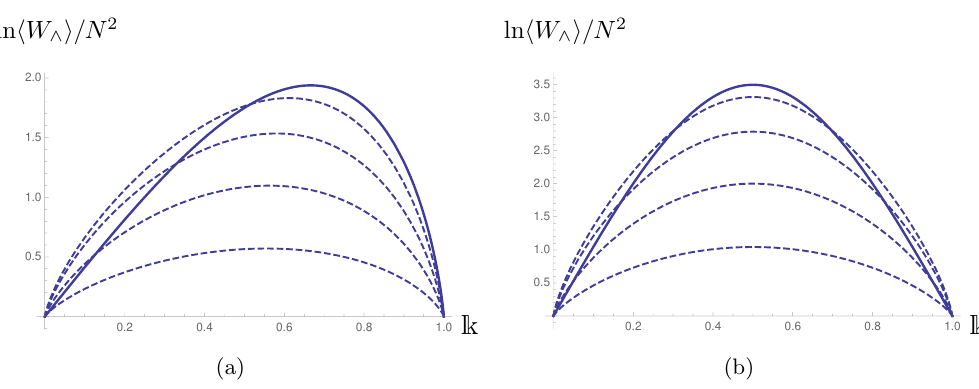
(cid:8) 1 (cid:9) ; : : : ; 4 , the solid curve is for z = 1 10 10